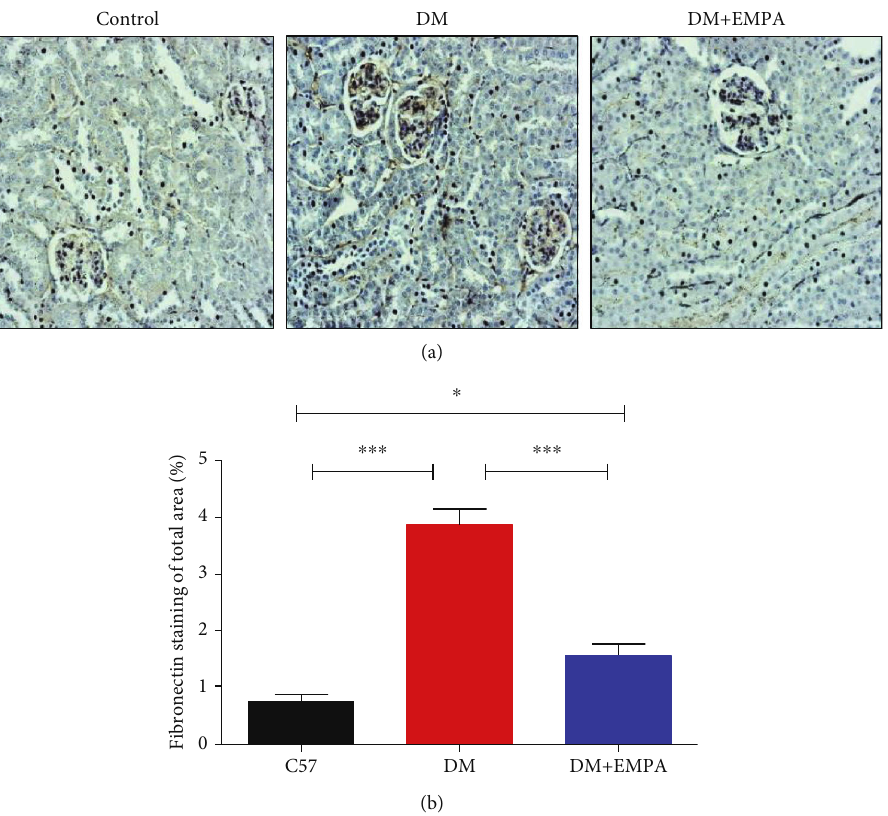
Figure 7: (a) Representative IHC staining for fi bronectin in mice renal sections (magni fi cation × 20). (b) Quanti fi cation of fi bronectin expression. Renal fi bronectin expression was signi fi cantly increased in DM mice compared with C57/Bl and DM+EMPA